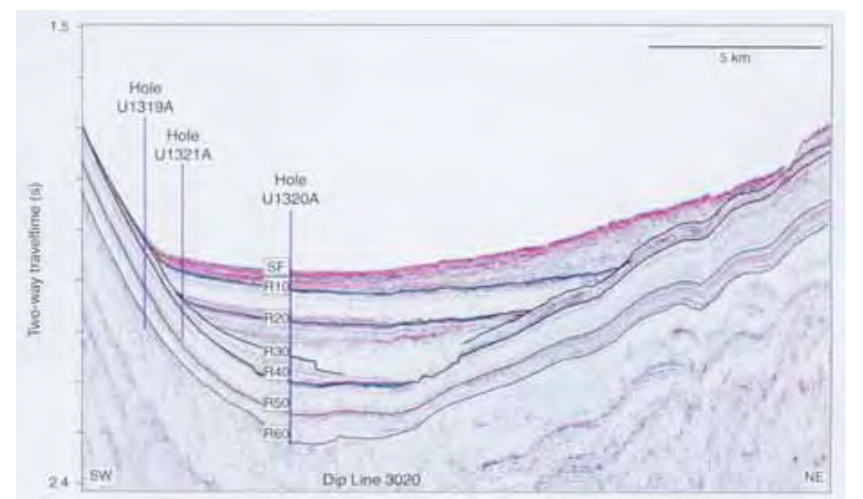
Figure 3. Refl ection seismic section (Dip Line 3020) across Brazos Trinity Basin IV. Specifi c drill sites are located at cross-tie with strike Line 3045 (Site U1320), strike Line 3055 (Site U1321),